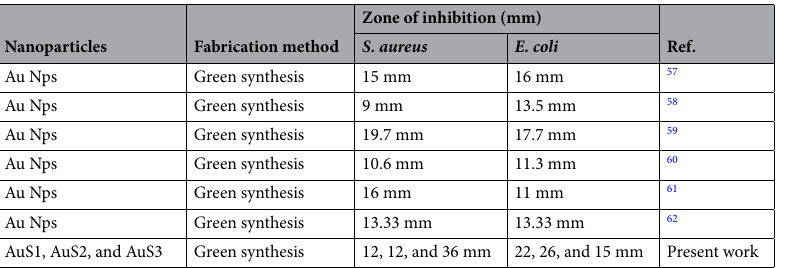
Table 4. Comparative study of gold nanoparticles for antimicrobial efficacy against E. coli and S. aureus.